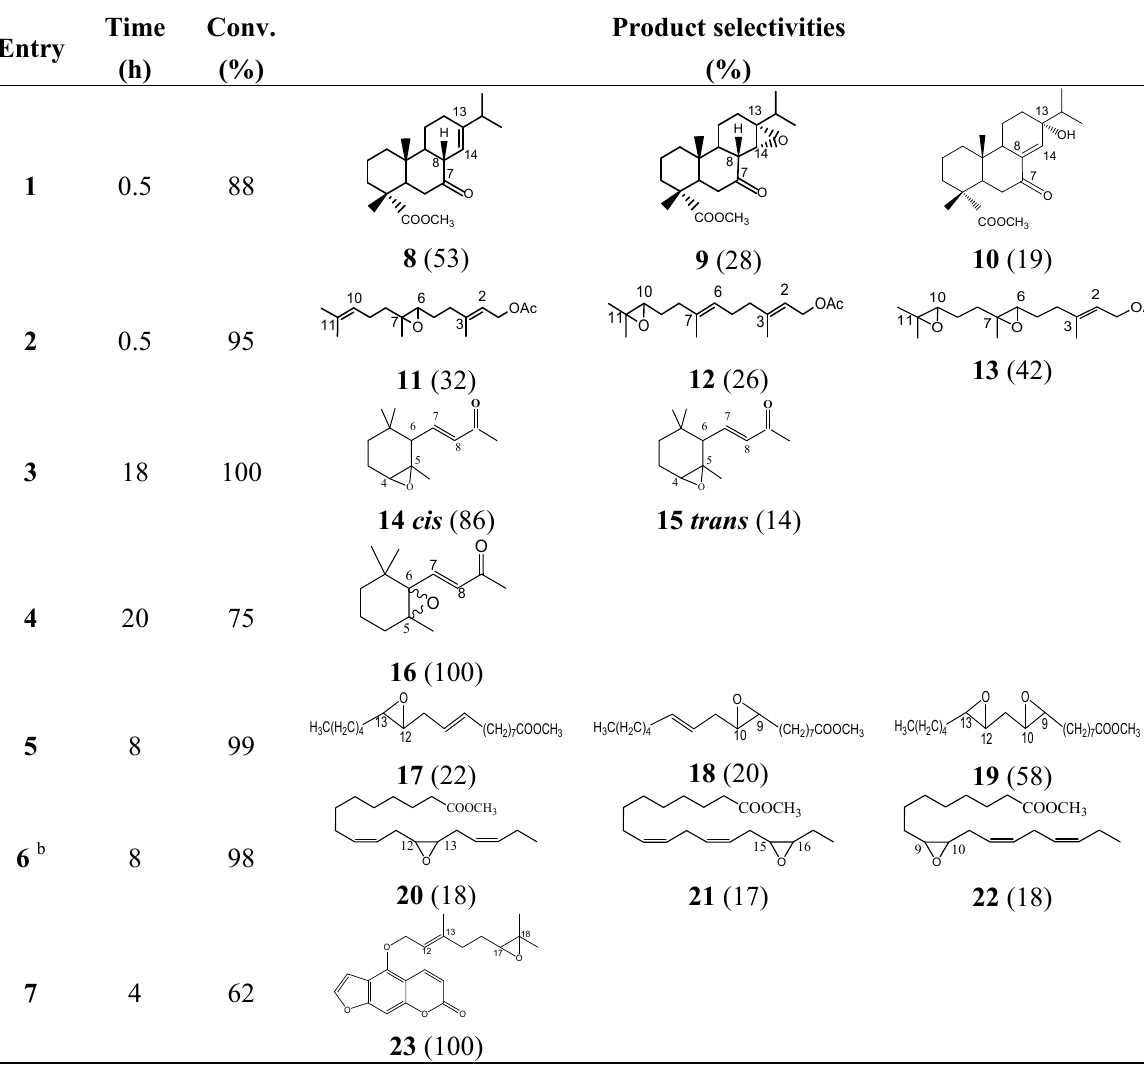
O /pyridine in 2 2